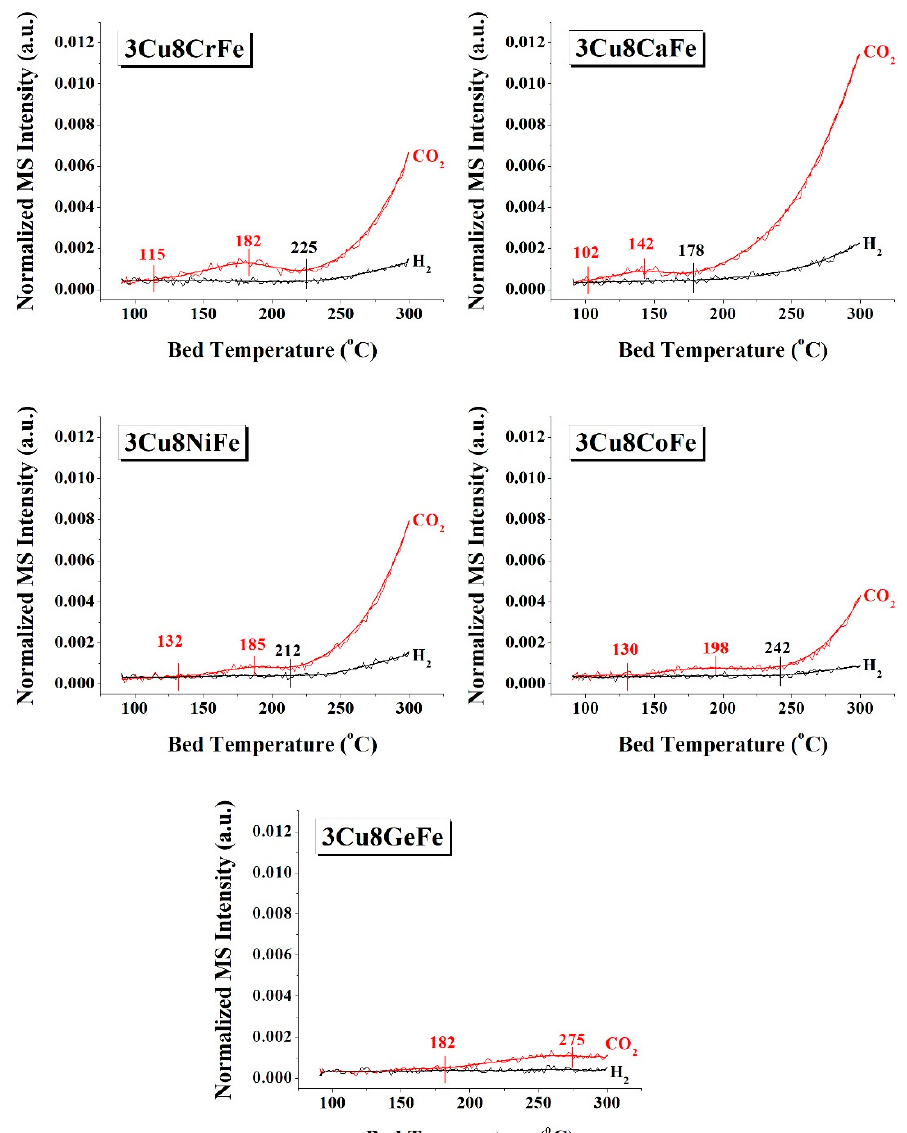
Figure 4. Evolution of H 2 and CO 2 as a function of catalyst temperature for various 3Cu8MFe catalysts (M = Cr, Ca, Ni, Co, and Ge). The thin zigzag line represents the actual data points and the bold solid line passing through the data points is the moving average for the respective data points in each curve.